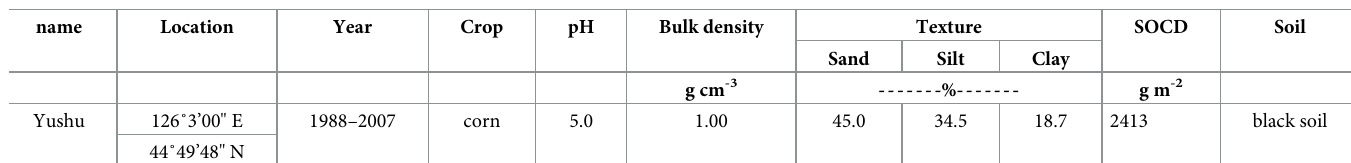
Table 1. Site characteristics (0–20 cm) for the field-validation site in Jilin